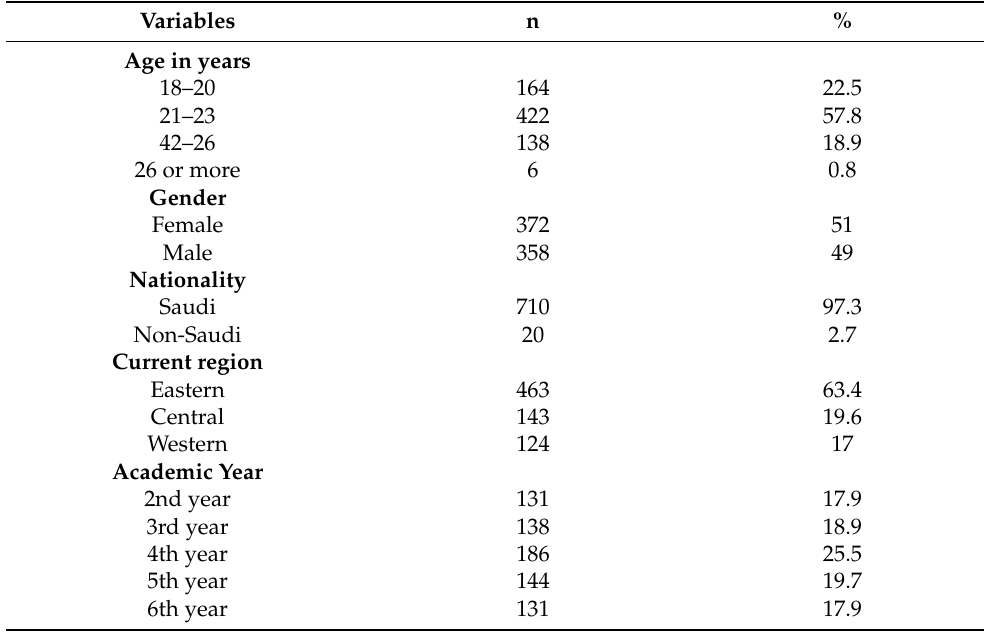
Table 1. Demographic data of study participants (n =